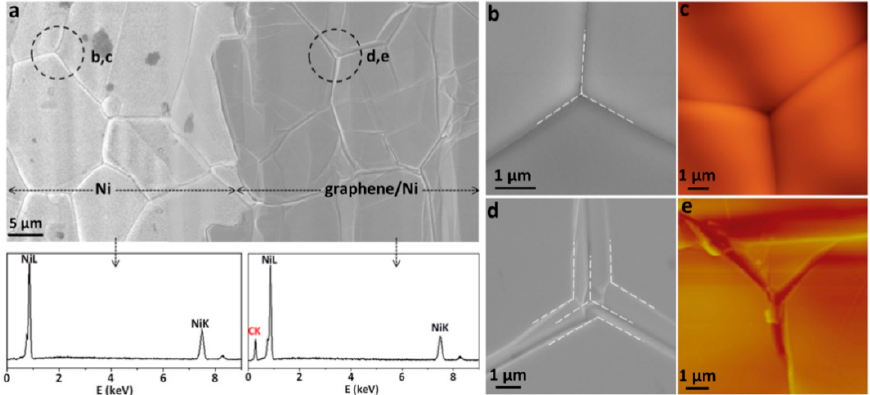
Figure 18. ( a ) FESEM image recorded at the interface of Ni (left) and graphene/Ni (right). The absence and presence of graphene in two regions are confirmed with the EDAX spectra shown below them. The circles represent the scenarios in ( b ) and ( d ) where grain boundaries meet. A FESEM and AFM image of annealed Ni foil ( b , c ) and graphene peeled-off Ni foil ( d , e ). z-scale: 1 μ m. Dashed lines are drawn for easy guide. (reprinted with permission from [136]).